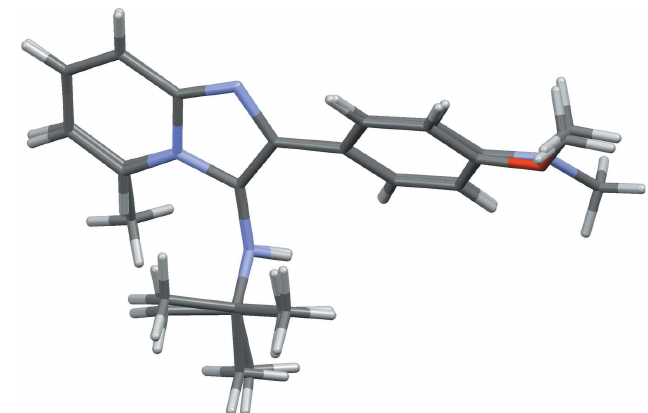
Figure 1 The molecular structure of compound (I), with the atom labelling. Displacement ellipsoids are drawn at the 50% probability